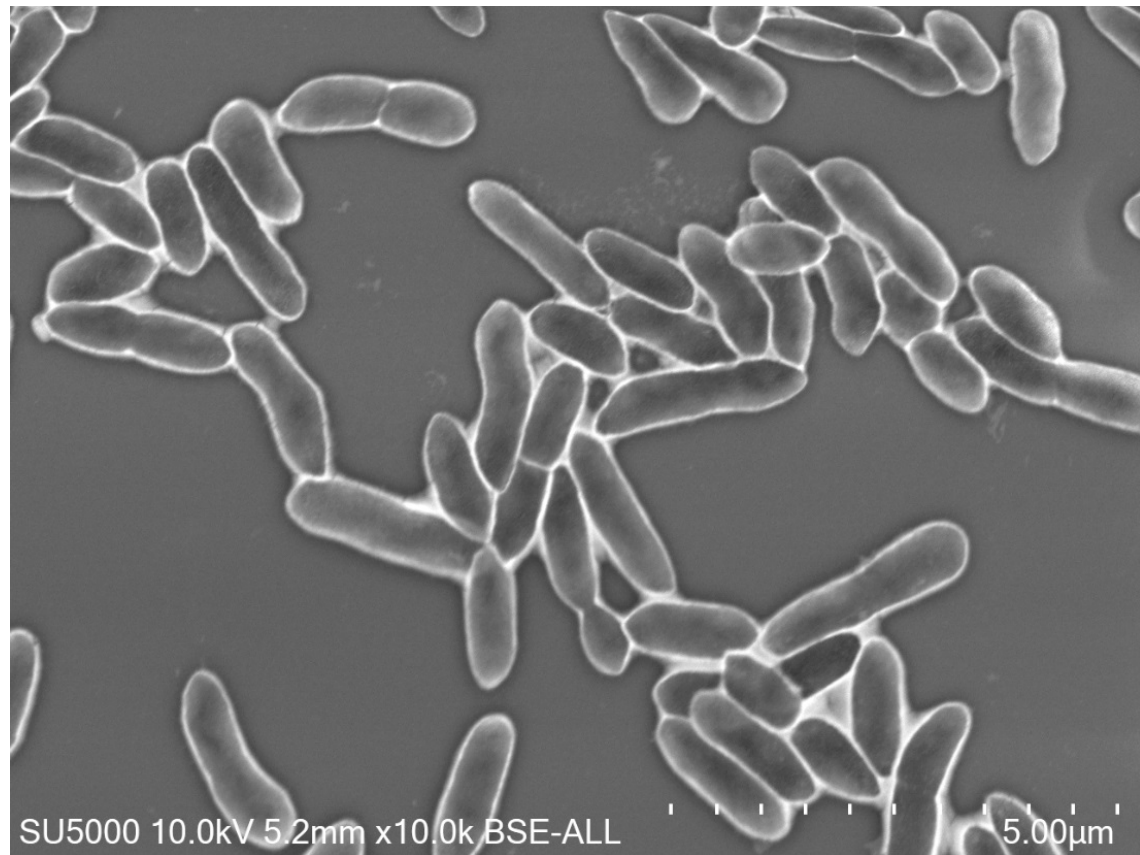
Figure 5. Transmission electron microscopy of the strain Marseille-Q2390. Bacterium was rod-shaped and without flagellum. Scale bar = 5 µm. Table 5. Physiological characteristics of strain Marseille-Q2390 and phylogenetically related species of the genus Pedobacter .